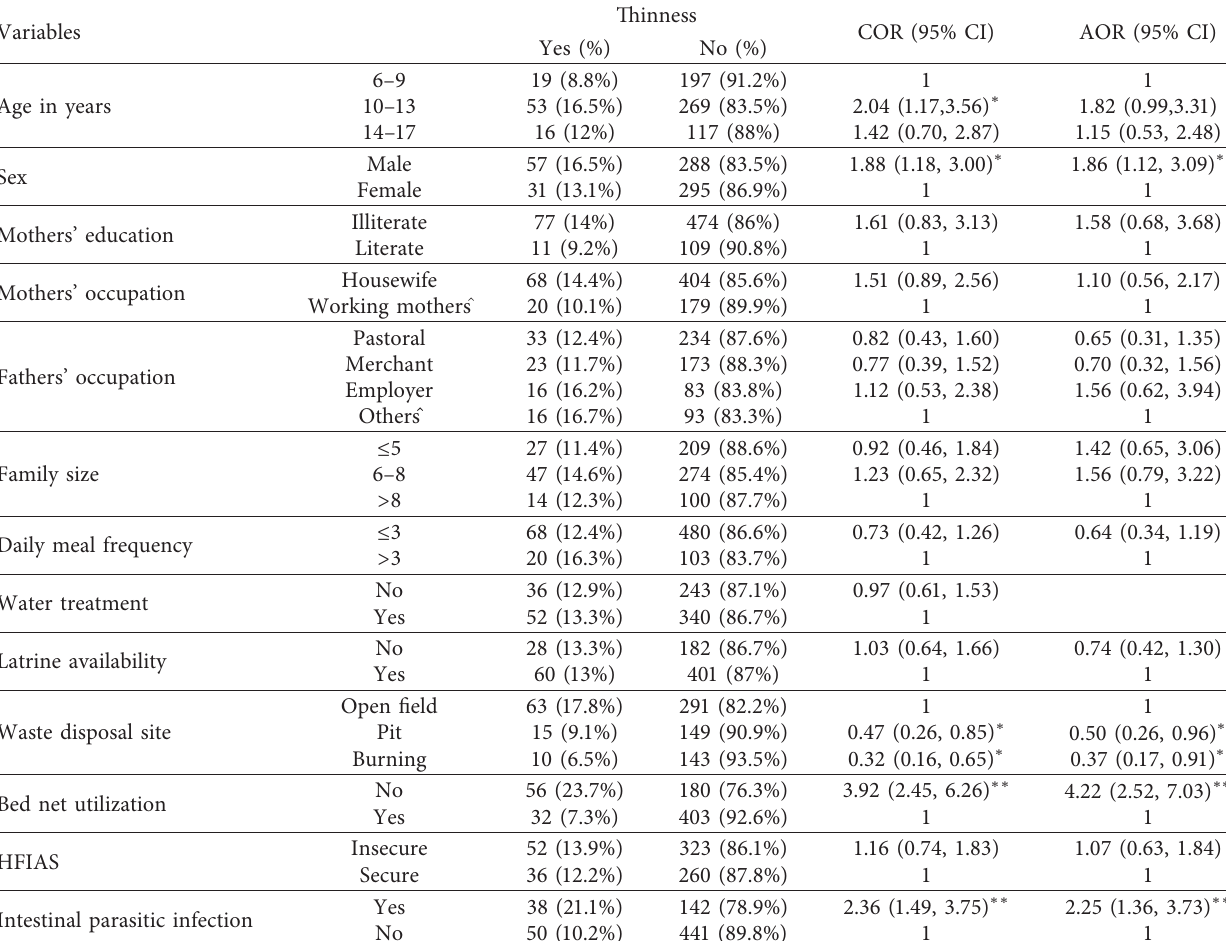
Figure 3: Magnitudes of stunting and thinness among children attending full-cycle primary schools in pastoral communities, Mieso-Mulu district, Sitti Zone, Somali Regional State, Eastern Ethiopia, 2019.